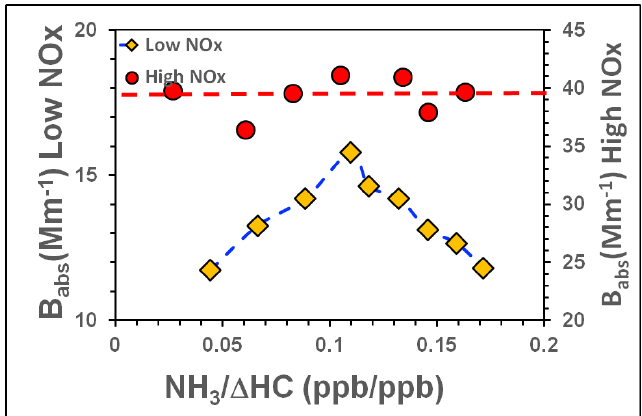
Figure 9. B abs as a function of the ([NH 3 ]/[ ∆ HC]) ratio at 80% RH under low and high NO x scenarios. Blue and red dotted lines are the eye guiding lines for low and high NO x scenarios, respectively. The dashed lines are included to guide the eye.